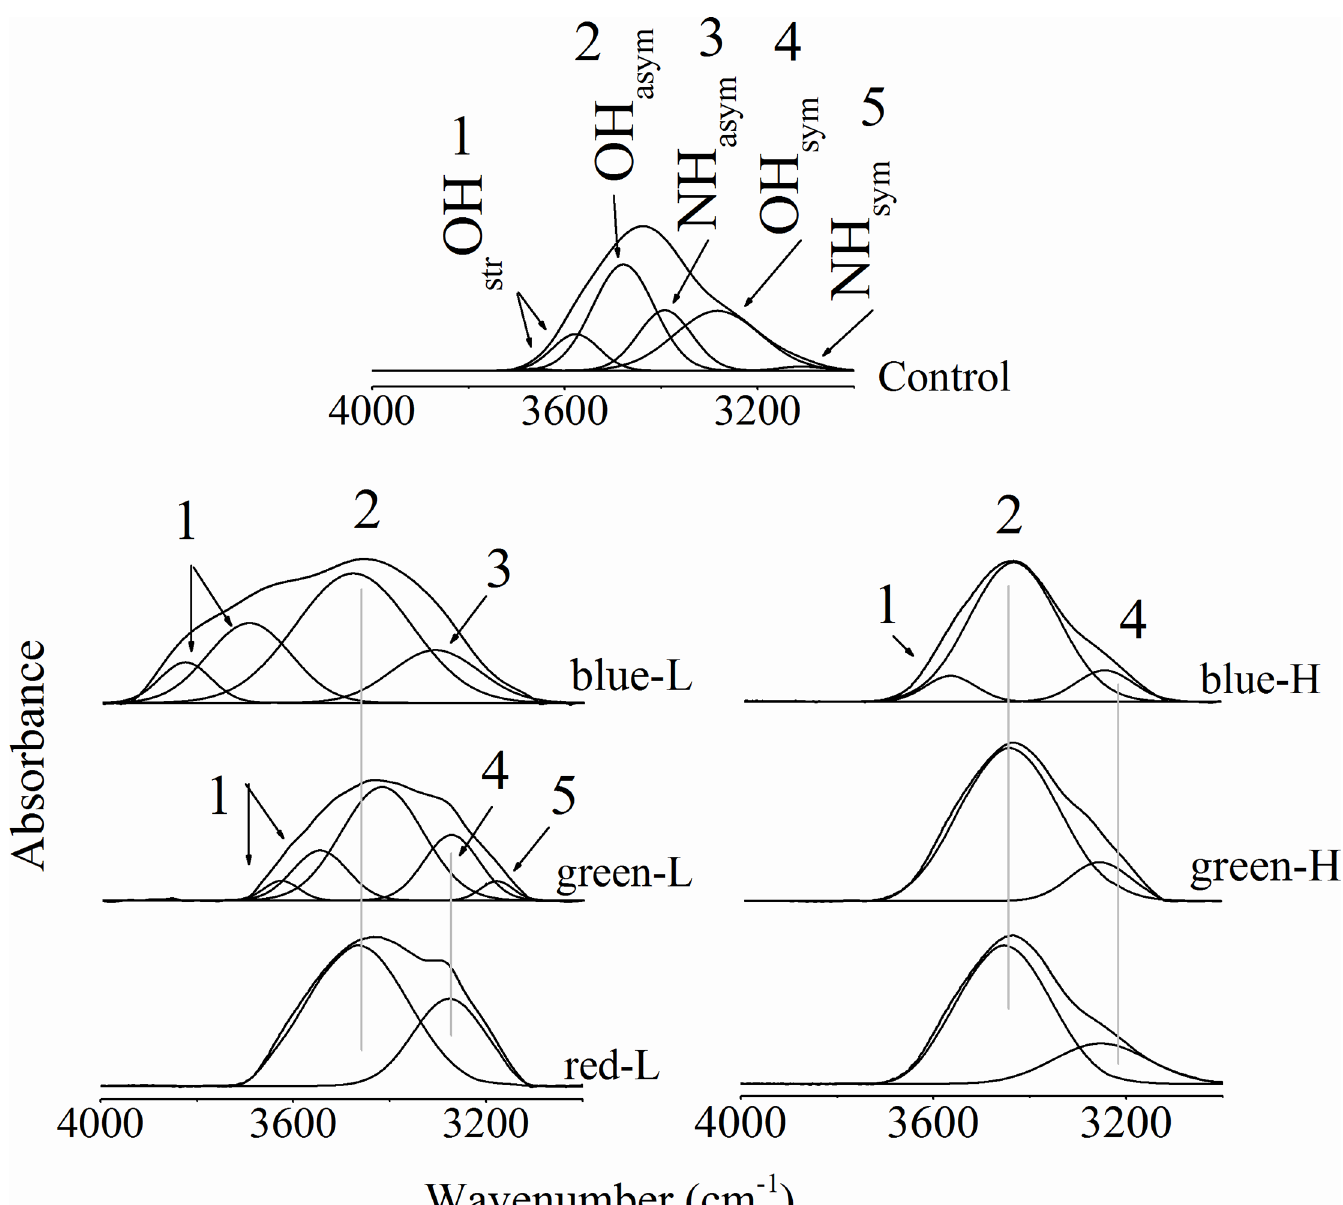
Fig 1. The main NH-OH band and its underlying peaks due to exposure to different color intensities.